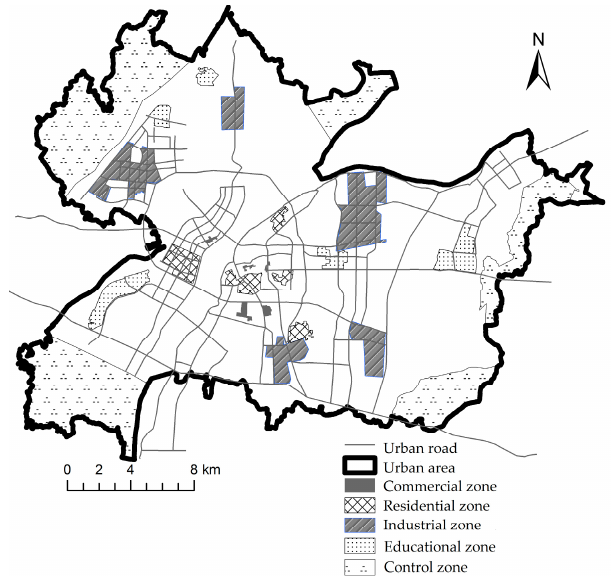
Figure 4. Location map of the urban functional zones in the Nanchang urban area.